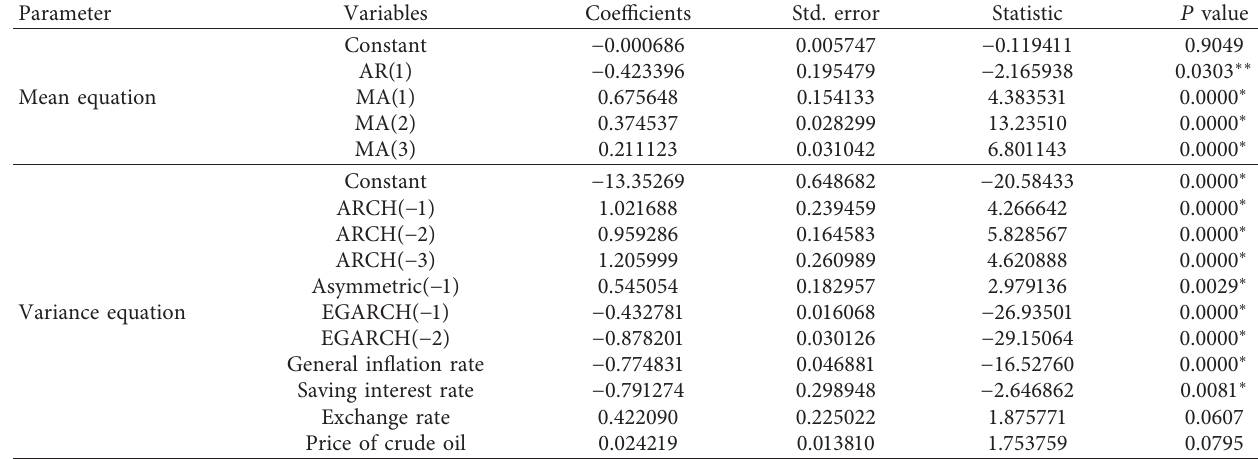
Table 7: ML parameter estimates of the ARMA (1, 3)-EGARCH (3, 2) volatility model under the normal distributional assumption of the residual for price return series of silver.